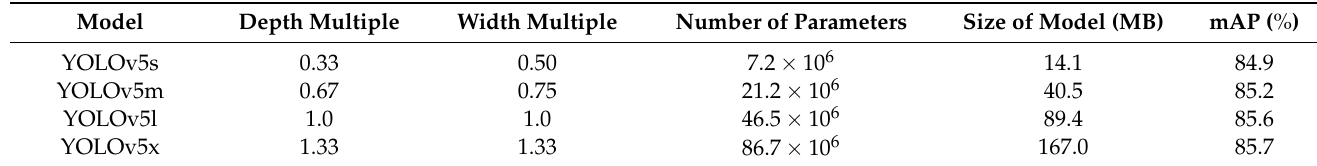
Table 3. Experimental results of different YOLOv5 models.